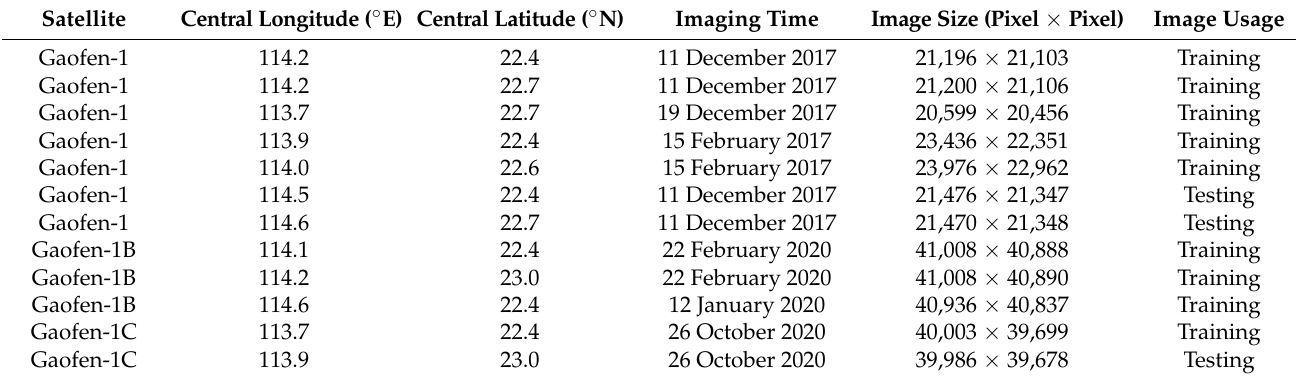
Table 1. Detailed information of the study data.